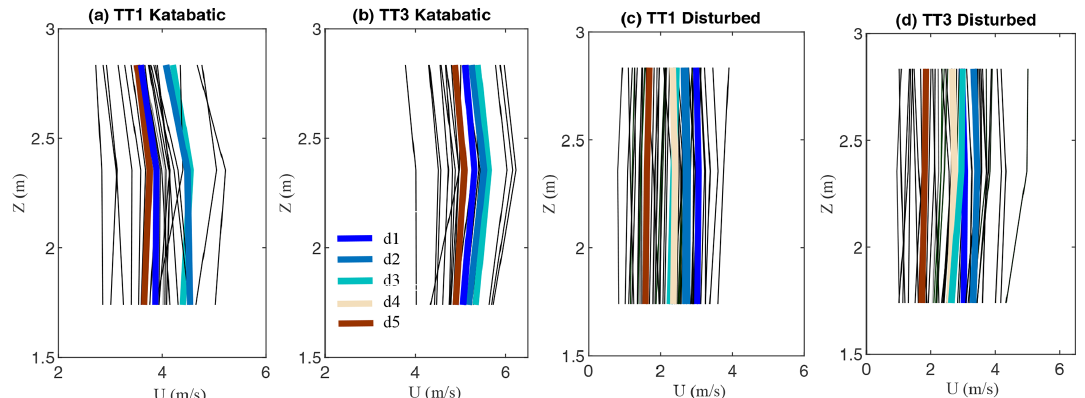
Figure 4. Profiles of 30min and daily (bold) averages of wind speed ( U ) measured during purely katabatic-flow and during disturbed-flow conditions at transect stations TT1 and TT3. Note that only 30min averaged data were considered to be purely katabatic if data showed katabatic flow during the entire 30min periods. Colours of bold lines indicate different measurement days.